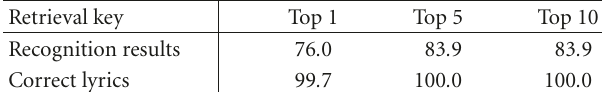
Table 3: Retrieval accuracy